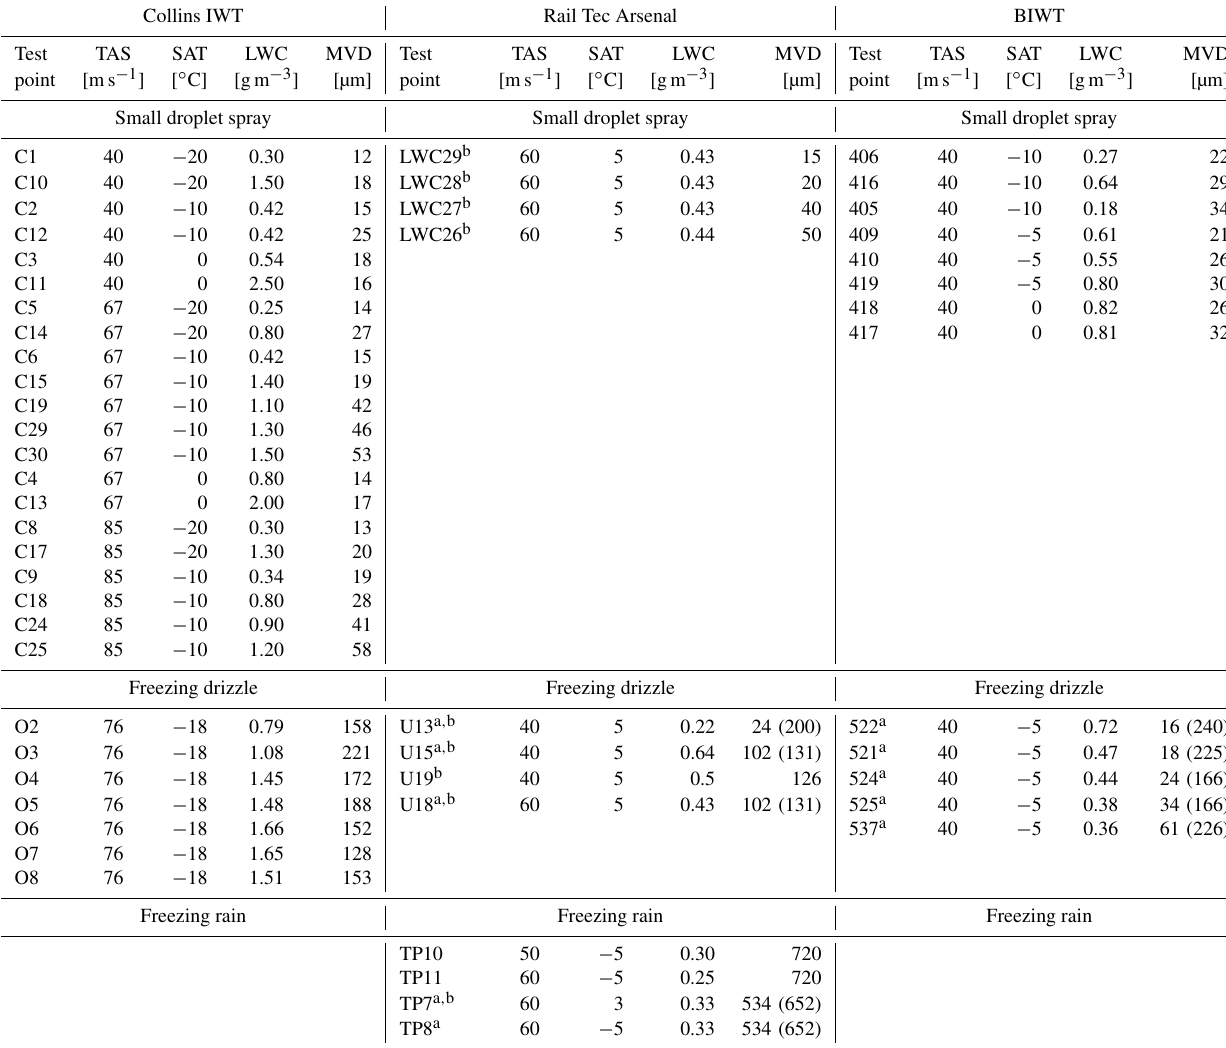
Table 3. Overview of the test points measured in the SENS4ICE and ICE GENESIS IWTs. The LWC values stem from the internal tunnel calibration. MVD values were derived from CCP measurements at the BIWT and Collins and from CAPS and Malvern measurements at RTA. For bimodal distributions, the diameter corresponding to the maximum of the large droplet mode is provided in brackets behind the